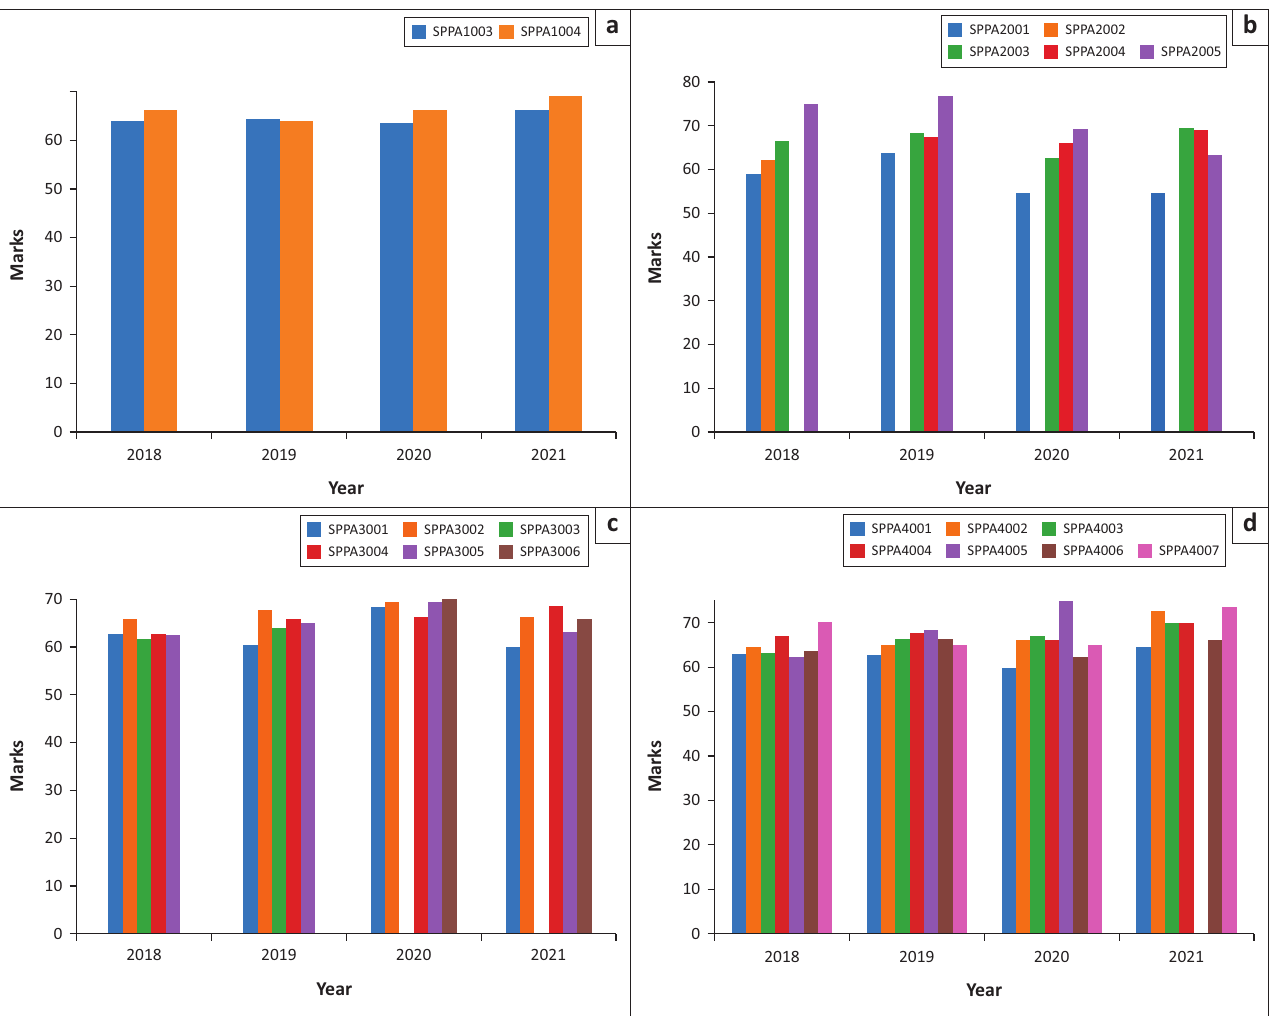
FIGURE 5: (a) First year students’ performance during face-to-face teaching and learning from 2018 to 2021, (b) course performance for second year, (c) students’ performance for third year and (d) students’ performance for fourth